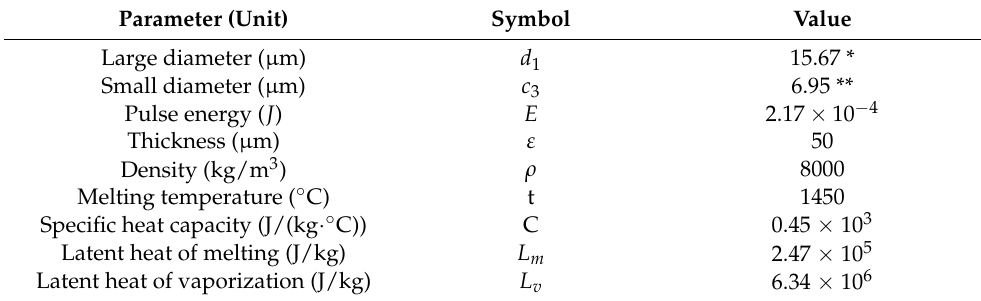
Table 2. Related parameters of the metal